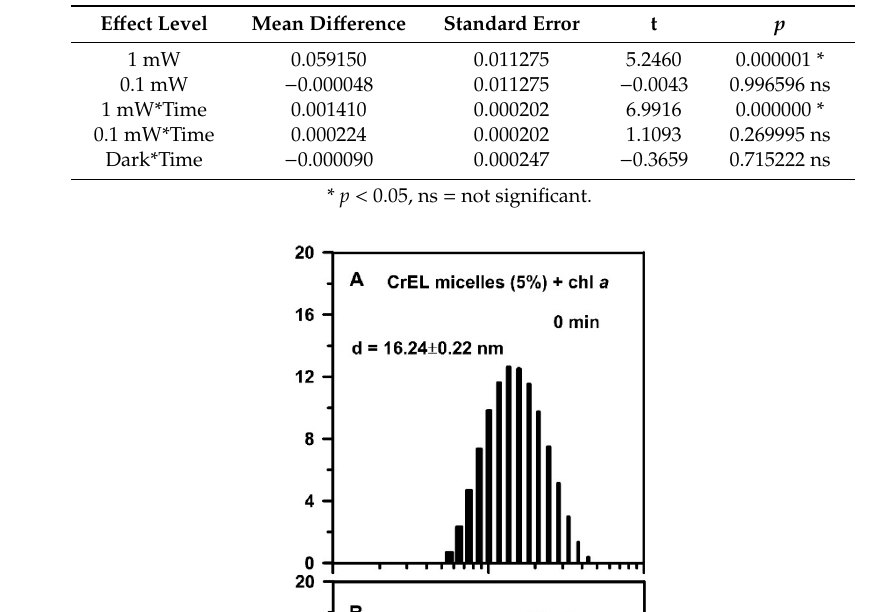
Table 1. Significance of the power of light, exposition time and interactions based on the value of B x / Q y for dark-adapted chl a and illuminated with white light for 60 min.